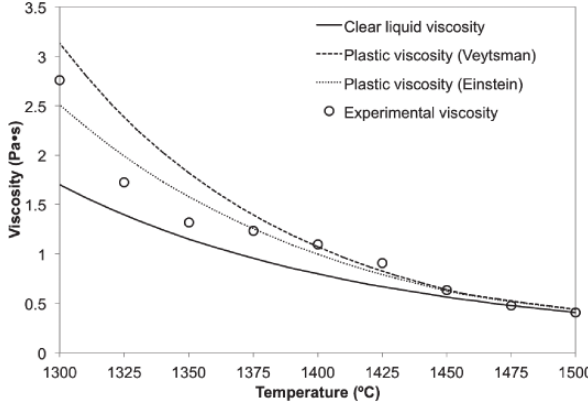
Fig. 7: Predicted viscosity using Veytsman and Einstein Models vs Experiment using solid fraction including